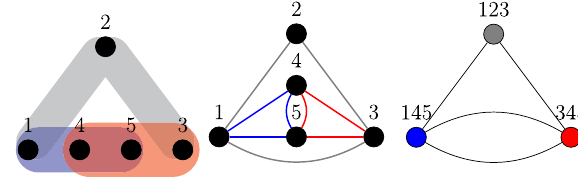
Figure 1: Clique ( ) (cid:4) (cid:2) and line ( ) (cid:5) (cid:2)